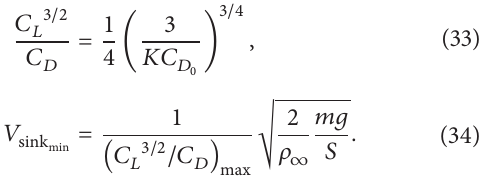
figuration aims to optimize the time management of the mission phase with respect to the elevation angles of the sun to maximize solar energy. Flying according to the sun’s